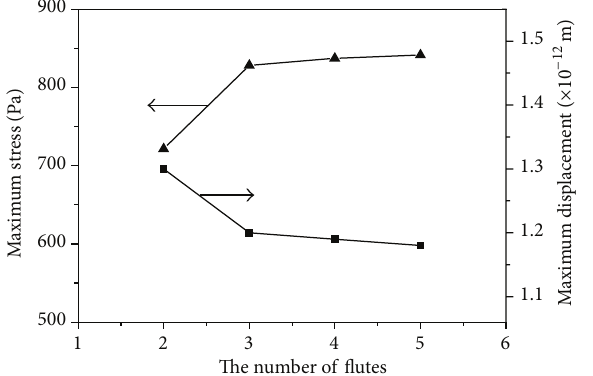
Figure 8: Maximum stresses and maximum displacements of corrugated board models with different flute height.